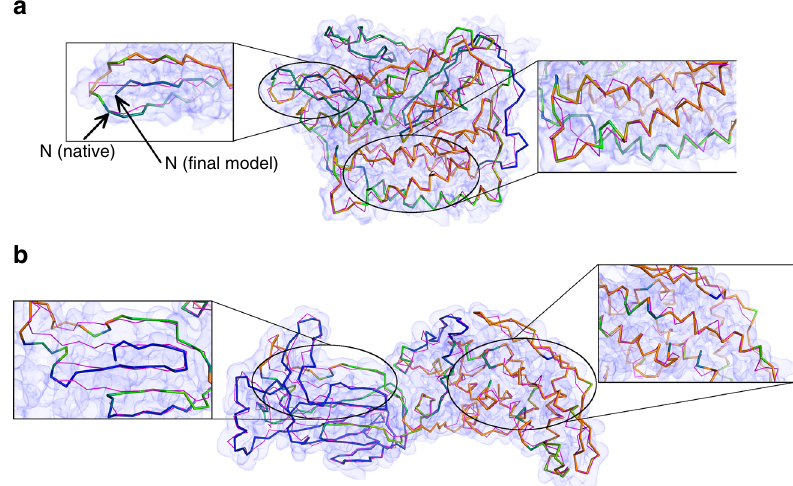
Fig. 5 Models with con fi dence level in colors. a F420-reducing hydrogenase α subunit at 3.36 Å resolution (EMD-2513). The top-scoring MAINMAST full- atom model after the re fi nement had an RMSD of 3.8 Å, a coverage of 0.92, and a precision of 0.91 while the C α model before the re fi nement was at an RMSD of 4.3 Å, a coverage of 0.88, and a precision of 0.88. The color code shows con fi dence of residue positions, which was computed by the degree of consensus among top 100 MDFF score models with blue to orange for low to high con fi dence regions. When only the residues that had consensus positions (within 3.5 Å) for over 50 models were considered (orange regions; 129 out of 385 residues), the RMSD was 2.1 Å. b rotavirus VP6 capsid protein at 2.6 Å resolution (EMD-6272). MAINMAST modeled it at 17.6 Å RMSD, Cov: 0.87, and prec: 0.86. Consensus residue positions over 50 models (orange regions) had an RMSD of 4.6 Å (180 out of 397